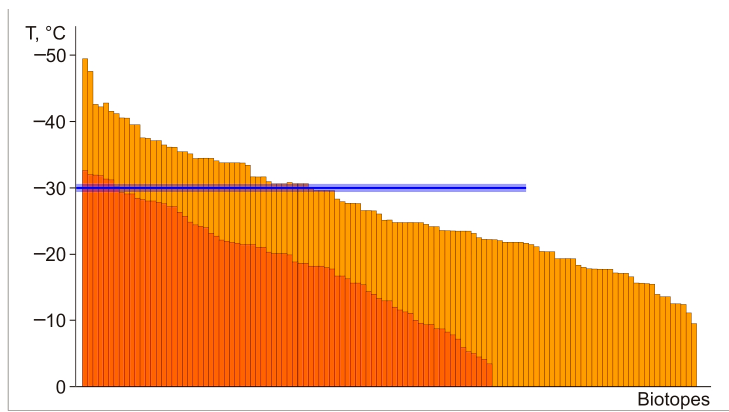
Figure 6. Annual minimum temperatures on the soil surface in 117 biotopes in the basin of the Kolyma upper reaches (yellow) and in 78 biotopes at the coast of the Sea of Okhotsk (orange) (the histogram is based on numerical data from [41]). The solid blue line is the identified threshold of temperatures intolerable by the small tortoiseshell.